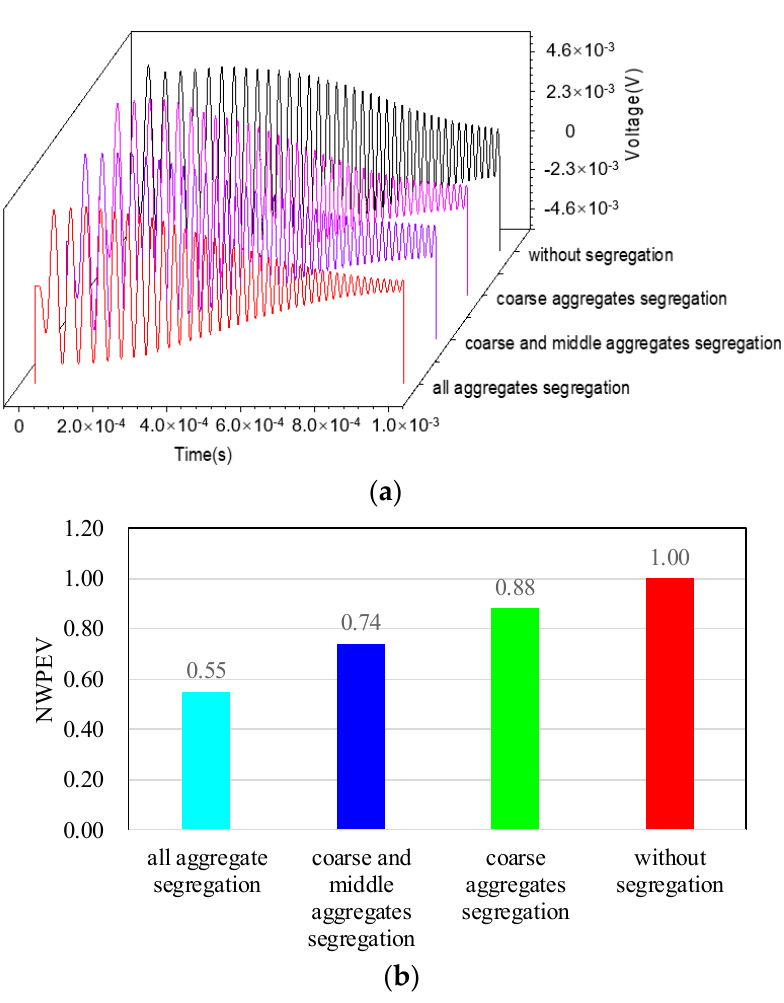
Figure 11. Output voltage and NWPEVs corresponding to aggregate segregation at different levels. ( a ) Time–history curves of the output voltage; ( b ) Normalized wavelet packet energy value.